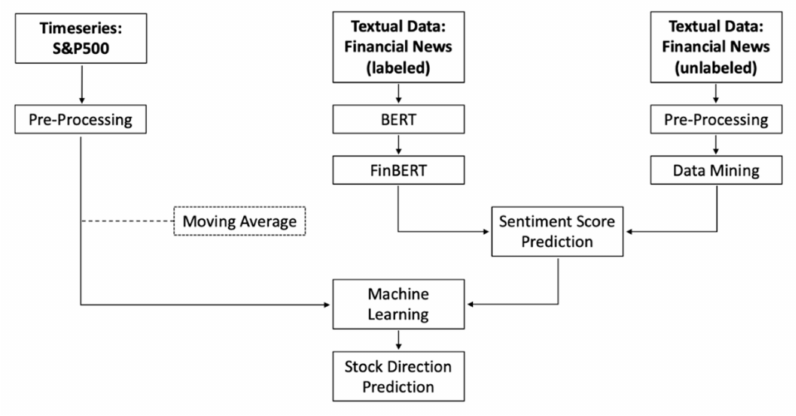
Figure 1. Overview of the empirical